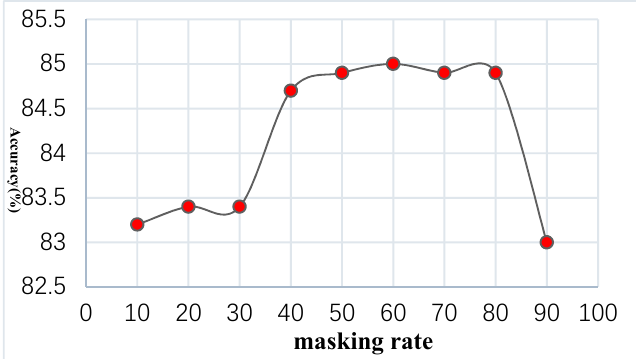
Figure 5. Influence of masking rate on classification